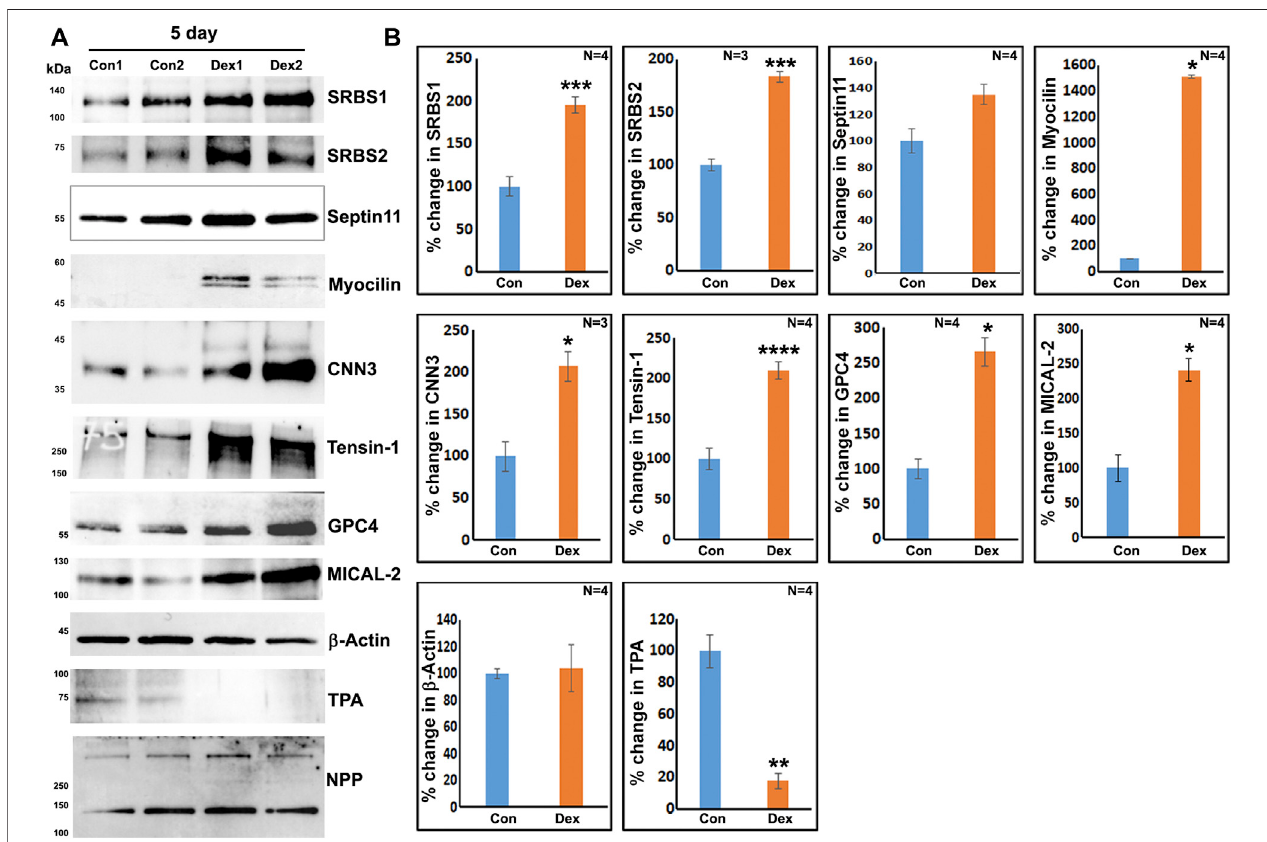
FIGURE 5 | Immunoblotting analysis based con fi rmation of elevated levels of selected proteins in the nuclear protein fraction derived from the 5-day Dex-treated human TM cells. (A,B) show the representative immunoblots for the indicated proteins and quantitative changes in levels of these proteins (histograms), respectively, in the nuclear protein fraction isolated from TM cells treated with Dex for 5 days. * p < 0.05; ** p < 0.01; *** p < 0.001; **** p < 0.0001. n = sample number. Immunoblotted proteins were normalized to the nuclear pore protein (NPP).